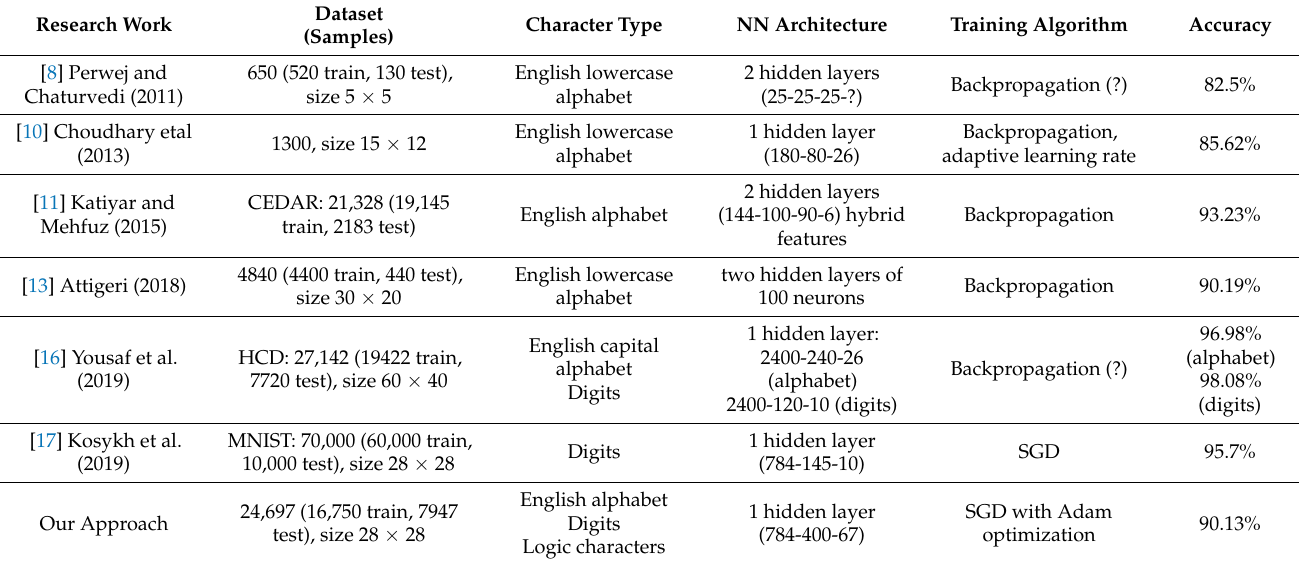
Table 6. Comparison of approaches for handwritten character